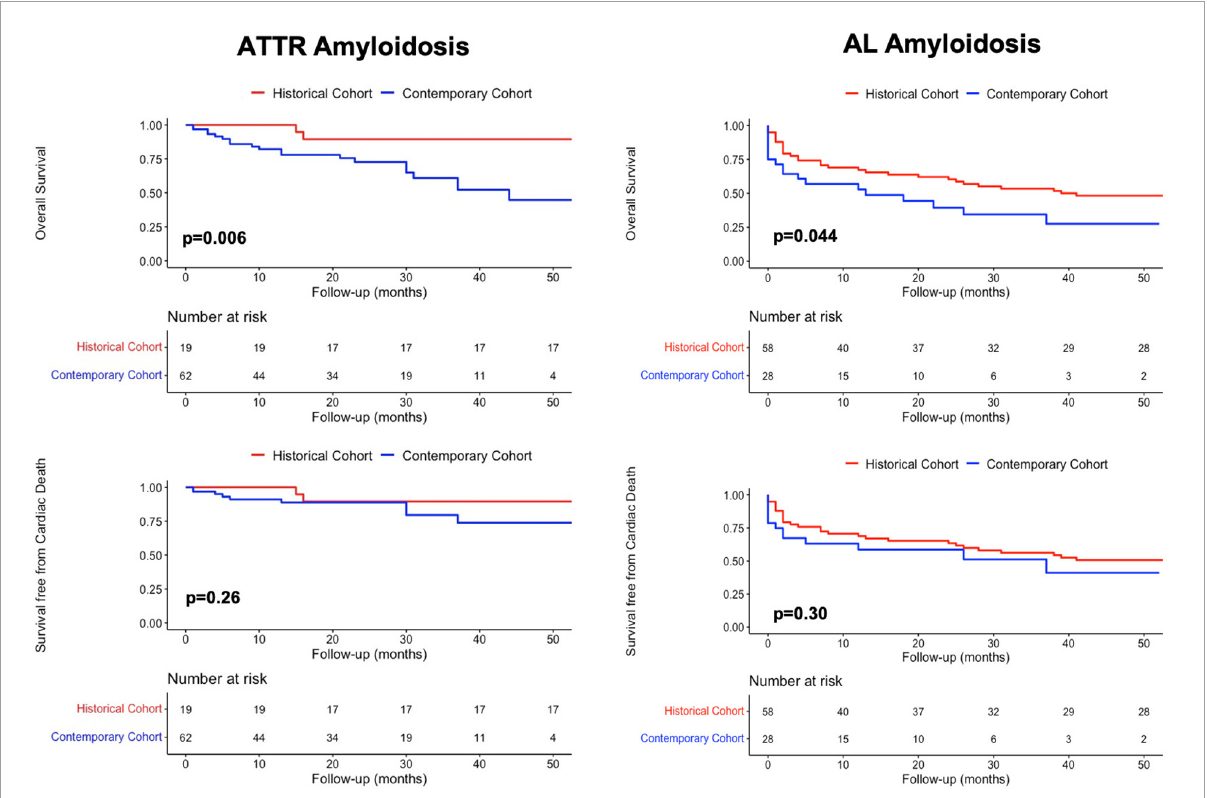
FIGURE3 Kaplan-Meier survival analysis in patients from the historical and the contemporary cohort with (Left column) ATTR amyloidosis and (Right column) AL amyloidosis for overall mortality and cardiac death. AL, Light Chain Amyloidosis; ATTR, Transthyretin